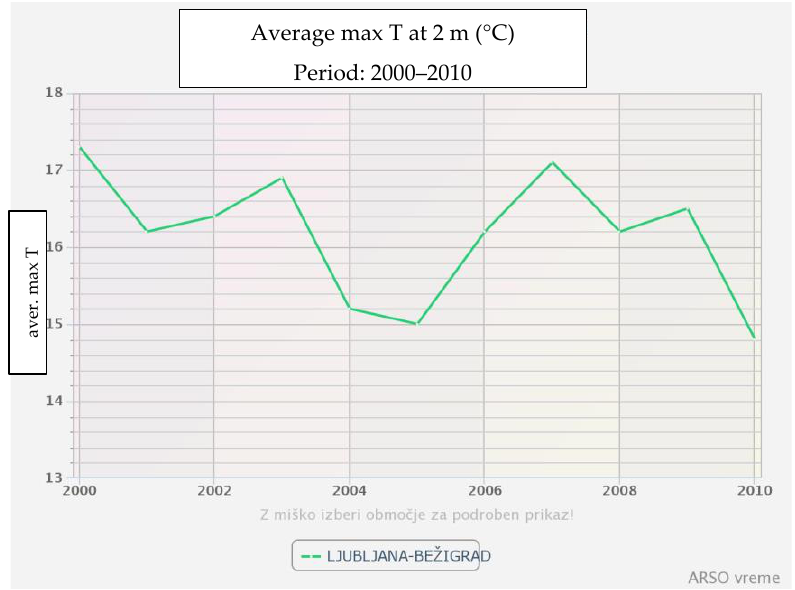
Figure 5. Average maximum temperature for localities 9 — Vrhnika, measured from nearby climate station Ljubljana (source: https://meteo.arso.gov.si/met/sl/archive, accessed on 27 January 2023).